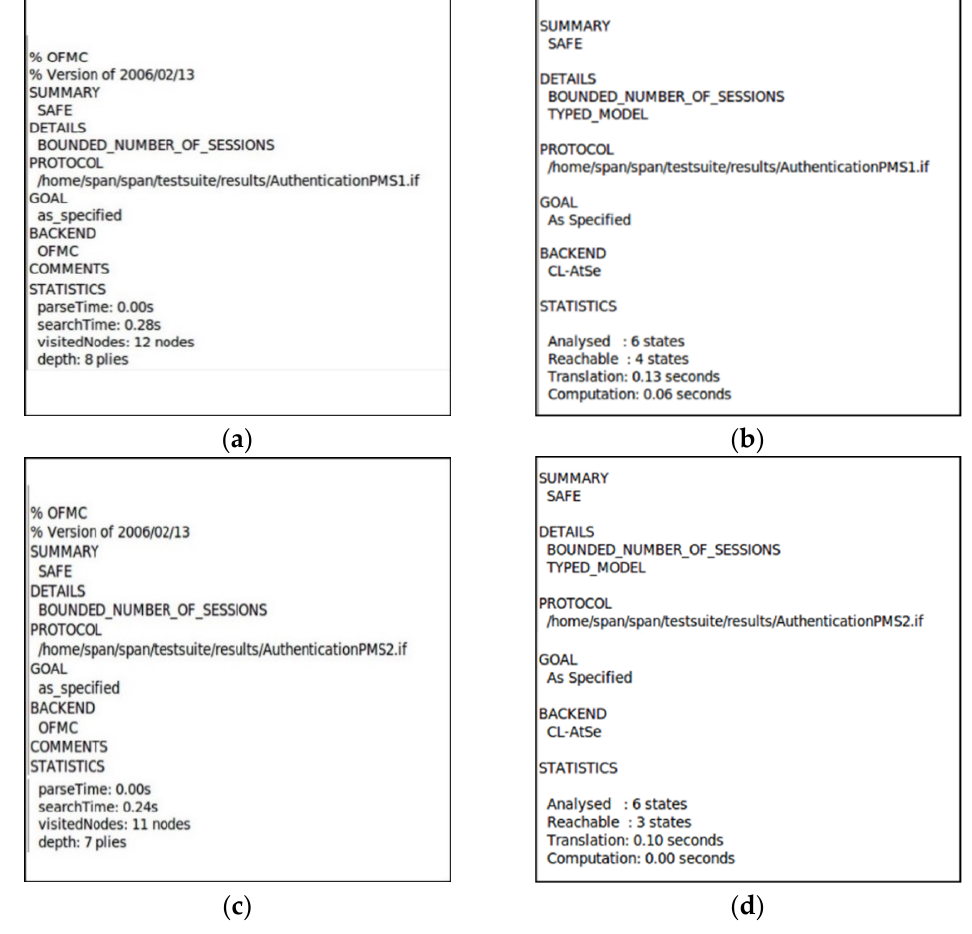
Figure 10. AVISPA with OFMC and CL-AtSe summary reports: ( a ) P-I OFMC report; ( b ) P-I CL-AtSe report; ( c ) P-II OFMC report; ( d ) P-II CL-AtSe report.